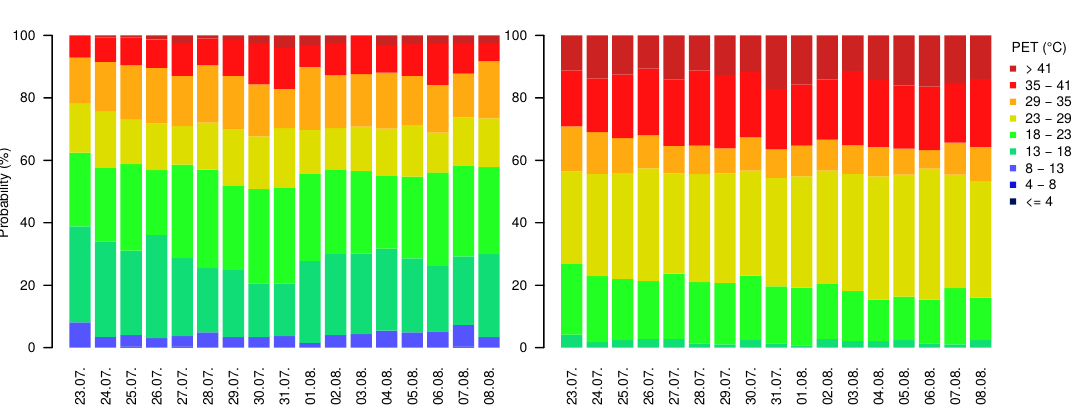
Figure 6. Frequency diagram presenting the average occurence of PET classes (Table 1) for Sapporo ( left ) and Tokyo ( right ) during the time of the Olympic Games 2020 based on the years 1966 to 2018. The x -axis denotes the dates of the days during the Olympic